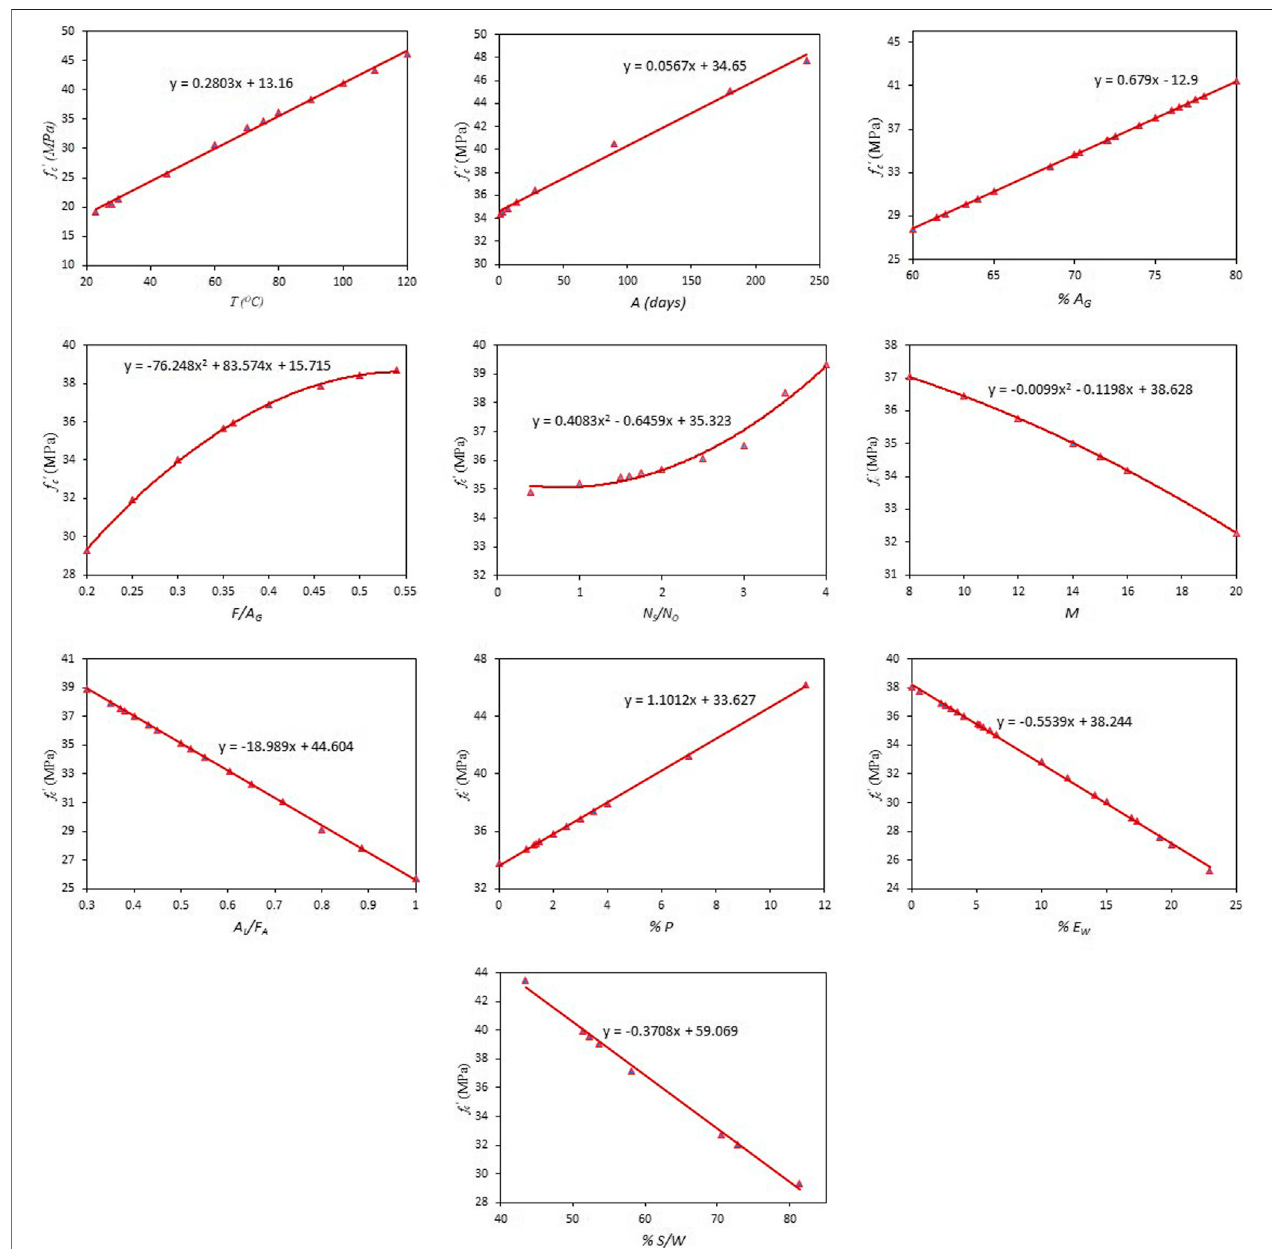
FIGURE 12 | Change in compressive strength by changing input